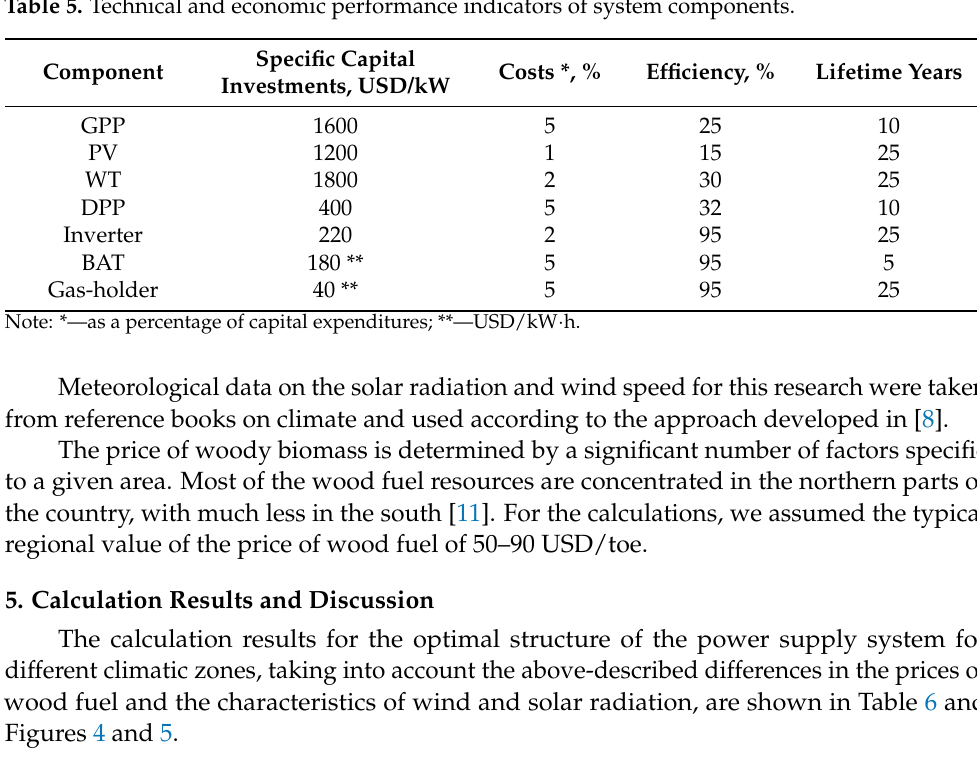
Table 6. The optimal structure of the power supply system for different climatic zones.